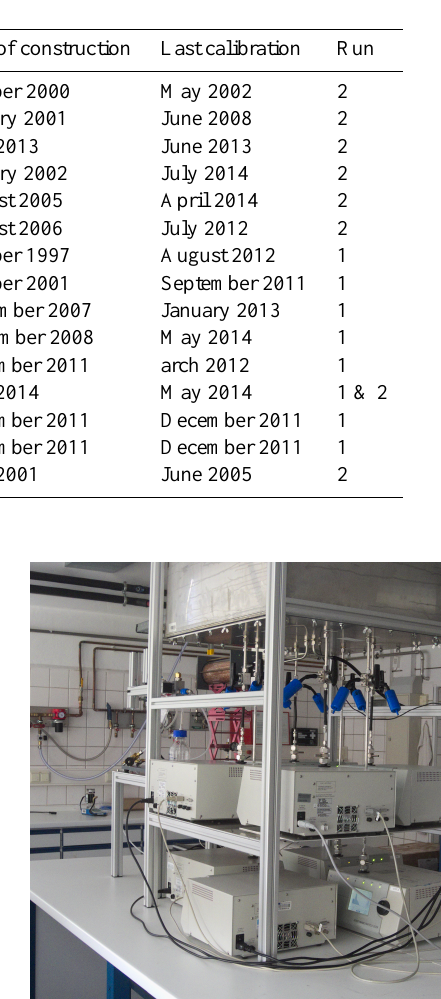
Table 1. Overview of compared TSI 3321 devices of the specific institute (Institute of Chemical Process Fundamentals ICPF, Institute for Atmospheric Sciences and Climate ISAC, Joint Research Center JRC, Navarino Environmental Observatory NEO, Leibniz Institute for Tropospheric Research TROPOS, Umweltbundesamt UBA, University of Helsinki UHEL) and sorted/indexed by age.